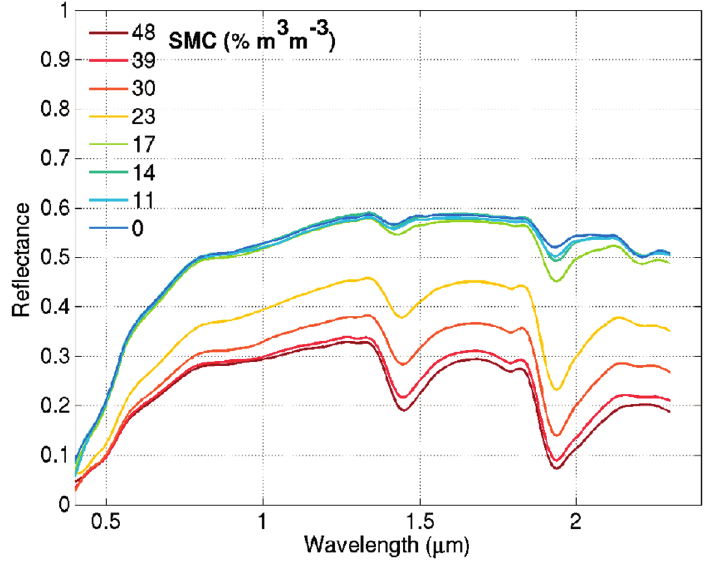
Figure 4. Evolution of the spectral signatures depending on the volumetric soil moisture content ranging between 0 and 48% m 3 ·m − 3 . The soil sample is composed with 30% of clay, 16% of sand and 54% of